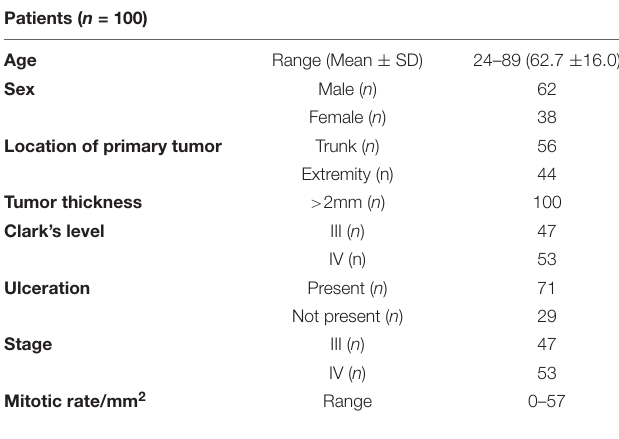
TABLE 1 | Clinicopathological data of the